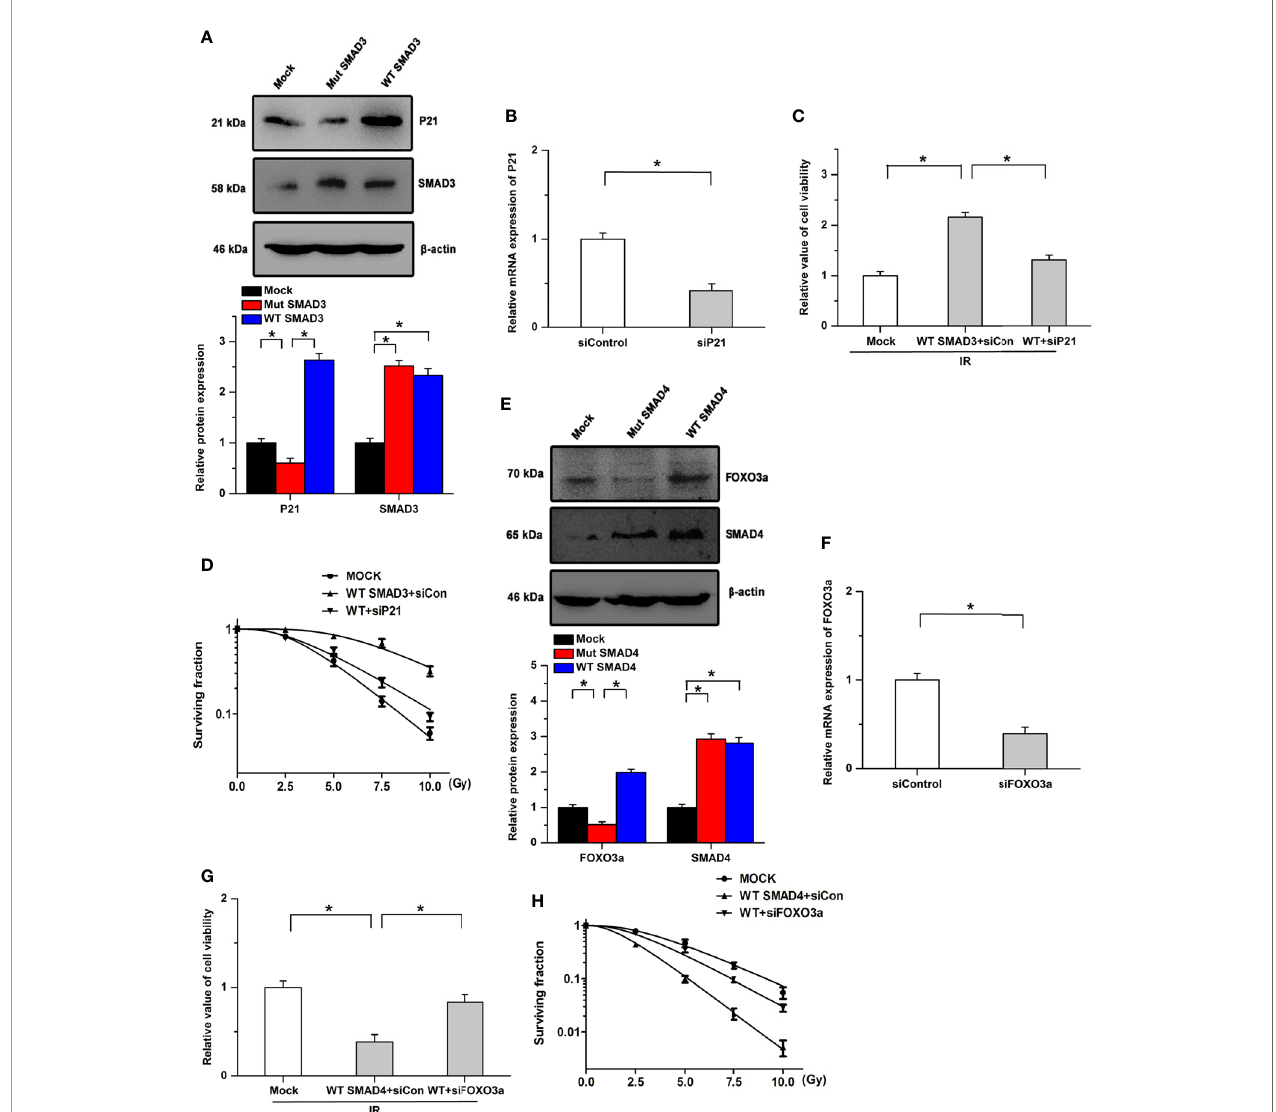
FIGURE 5 | Effects of SMAD3 and SMAD4 on radiosensitivity are mediated by different signaling pathways. (A) Expression of P21 was signi fi cantly increased by transfection of WT SMAD3, while the effects were abolished by the mutation of SMAD3. (B) Knockdown ef fi ciency of siP21 was veri fi ed by Real-time PCR. (C, D) SMAD3 inhibits IR-induced the decreases of cell viability (C) and surviving fraction (D) , which were mitigated by P21 knockdown. WT indicates WT SMAD3, siCon indicates siControl. (E) Transfection of WT SMAD4, but not SMAD4 mutation, increased the expression of FOXO3a. (F) Real-time PCR was utilized to determine the knockdown ef fi ciency. (G, H) Inhibitory effects of SMAD4 on the decreases of cell viability (G) and surviving fraction (H) induced by IR were attenuated by the knockdown of FOXO3a. WT indicates WT SMAD4, siCon indicates siControl. *P <